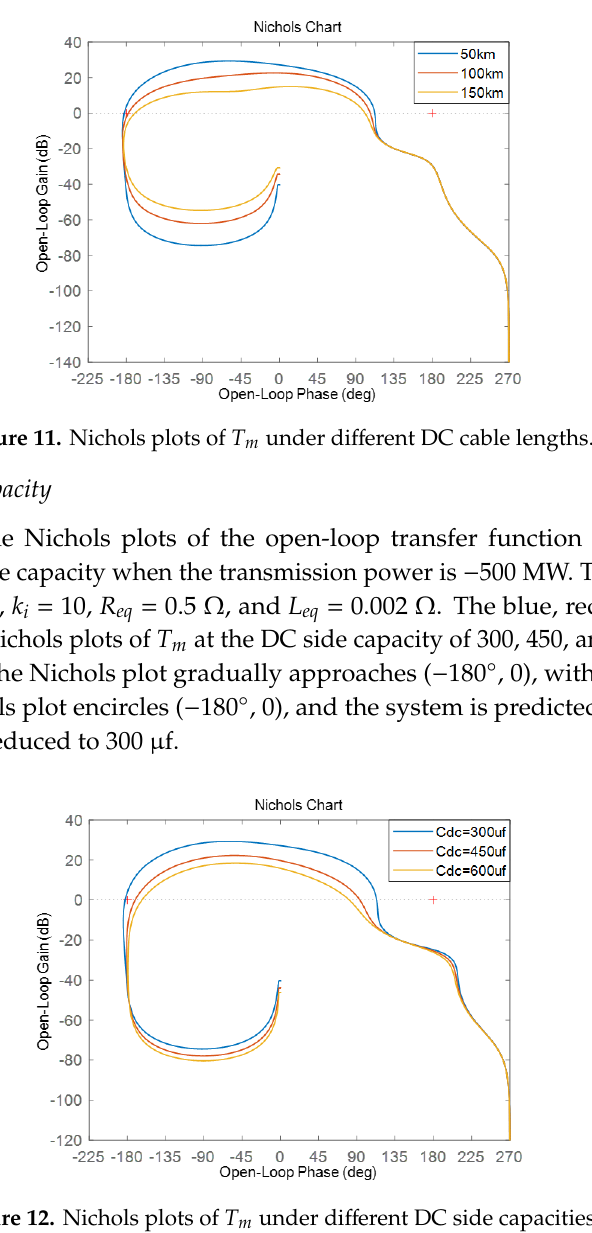
Figure 12. Nichols plots of T m under different DC side capacities.